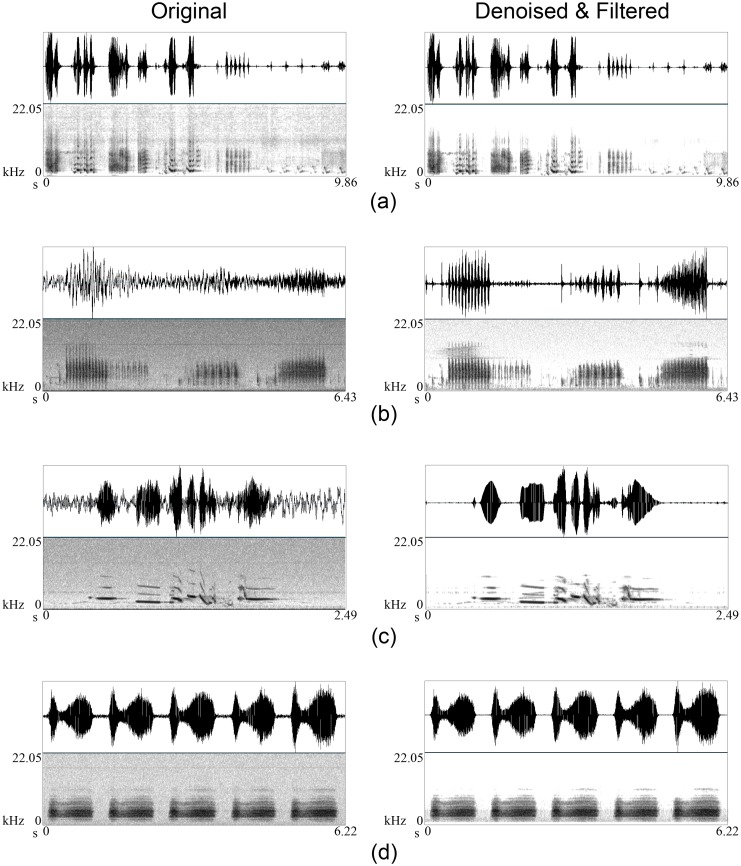
Denoising entire songs and long series of calls.(a) A North Island kaka song, (b) a marsh wren song, (c) a western meadowlark song, and (d) a series of kakapo chinging.